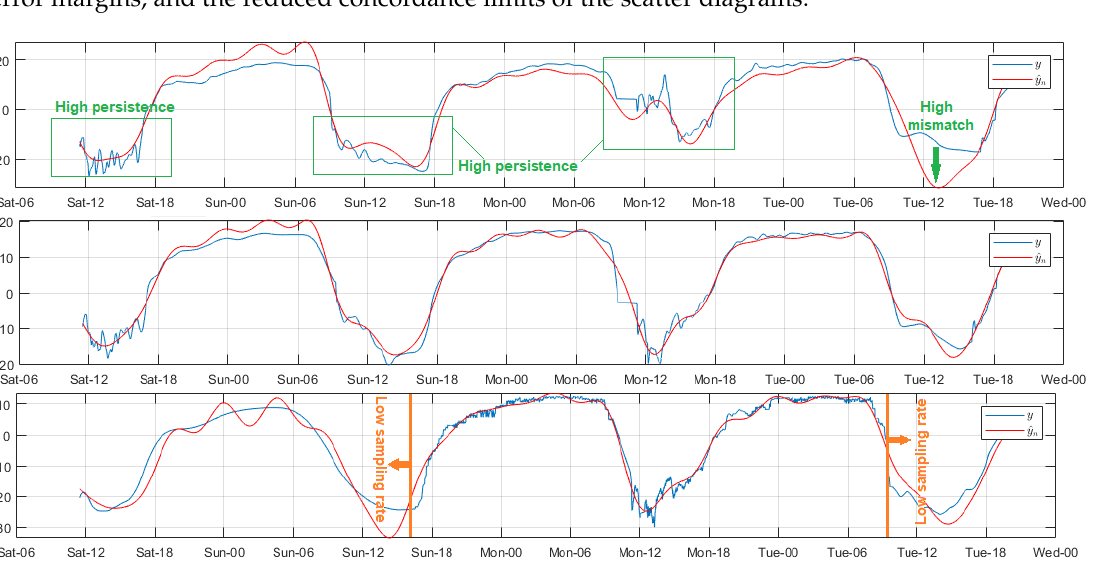
Figure 4. Representative modeled signals of air relative humidity. From top to bottom: Node 1 of DigiMesh network with Reg = 4, Node 2 of ZigBee network with Reg = 1, and Node 2 of WiFi network with Reg =